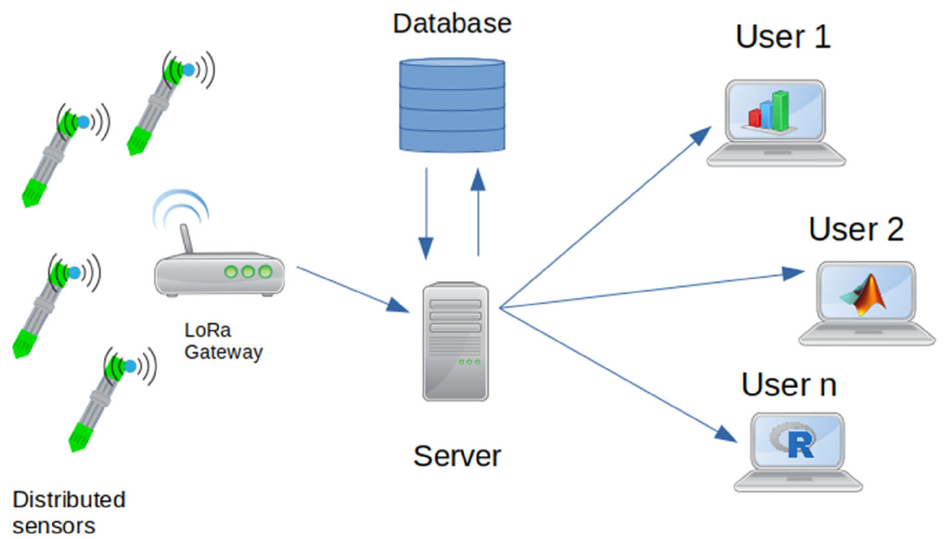
Figure 1. Distributed network concept.